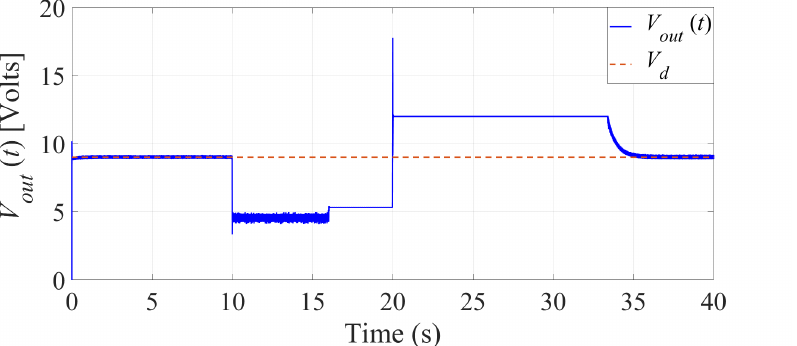
Figure 12. Scenario 2: Output voltage ( V out ( t ) ) implementing a classical PID controller (simulation 1).